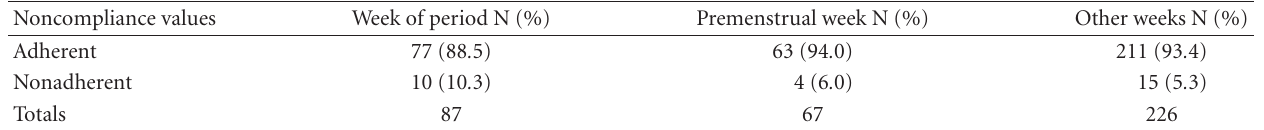
Table 2: Drug adherence during phases of the menstrual cycle. Chi square = 2.42; P > .